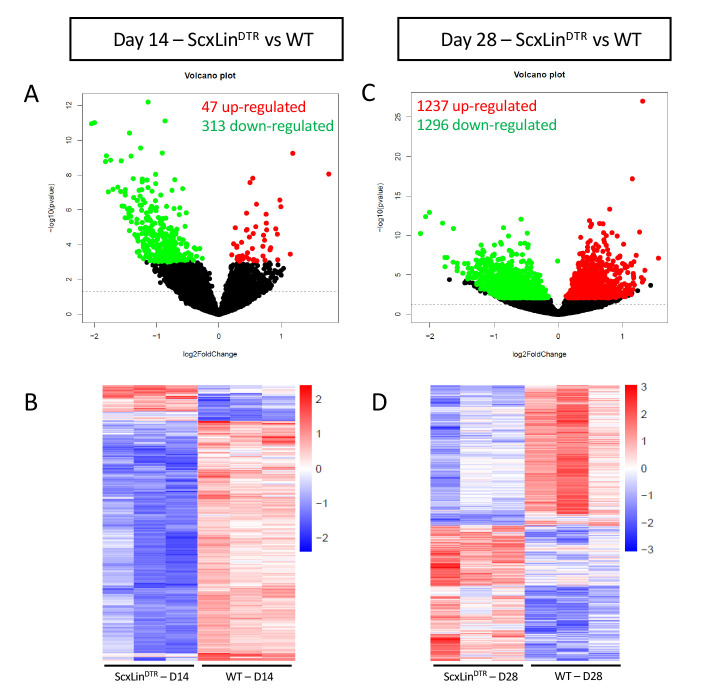
Bulk RNA sequencing reveals differences between ScxLinDTR and wild-type healing flexor tendons at 14 and 28 days post-repair.Representation of differentially expressed genes (DEGs) at 14 (A, B) and 28 (C, D) days post-repair. Volcano plots (A, C) depict significantly upregulated DEGs as red dots and significantly downregulated DEGs as green dots. DEGs are consider significant when the multiple test corrected (adjusted) p-value is < 0.05. The dotted line represents the unadjusted p-value of 0.05. Heat maps (B, D) depict all significant DEGs, with the data representing the regularized log transformation of the normalized count data.